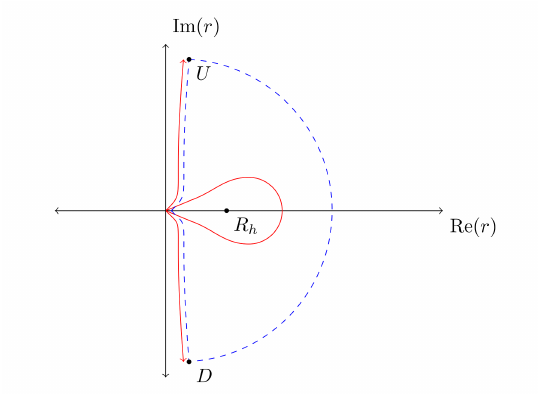
Figure 2 . Schematic depiction of the big contour, as the blue dashed line. The Stokes lines are depicted as red curves. Naturally, not all Stokes lines are depicted. Furthermore, we marked by D and U the regions where the boundary condition (3.15) may be imposed.